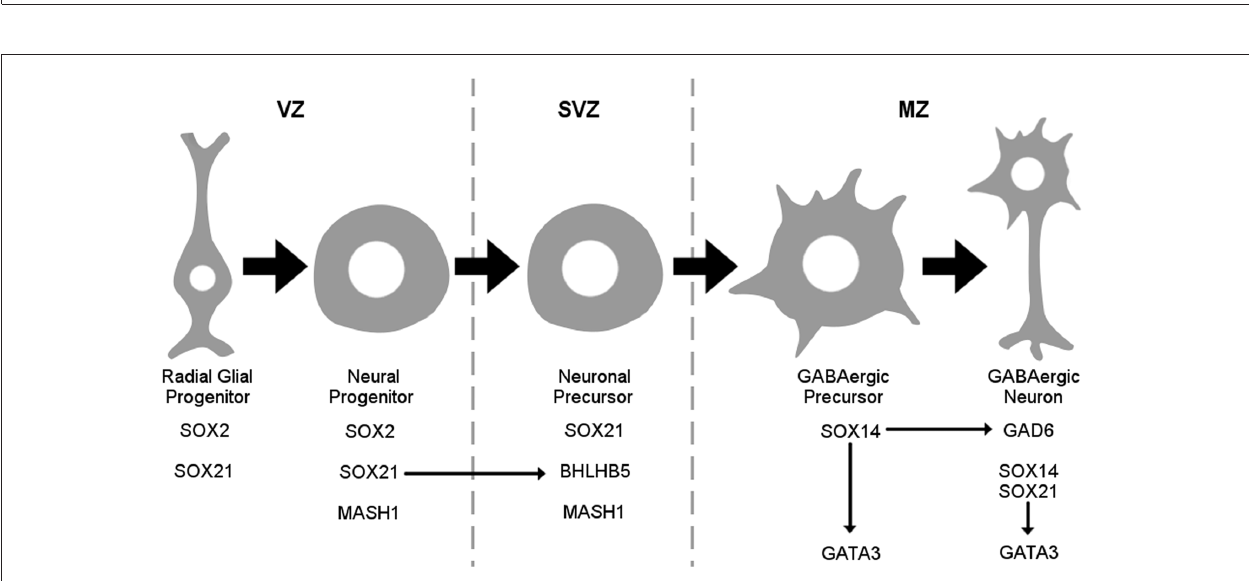
FIGURE 10 | Schematic representation of the SOX2B during maturation of GABAergic neurons. SOX21 is expressed both in radial glial and neuronal progenitors at the VZ while been maintained in neuronal precursors at the sub ventricular zone (SVZ) where it appears to govern the expression of BHLHB5. At the MZ SOX14 marks the GABAergic lineage while promoting GATA3